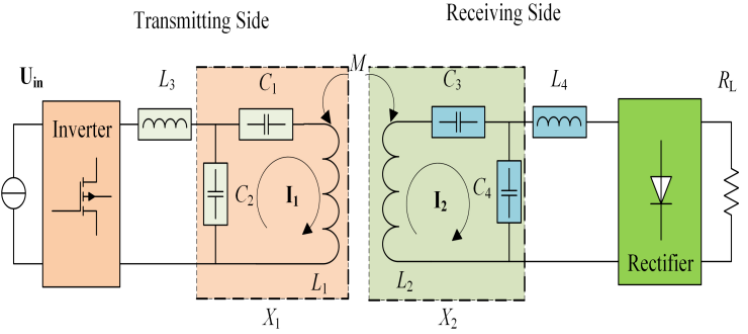
Figure 3. Topological structure.